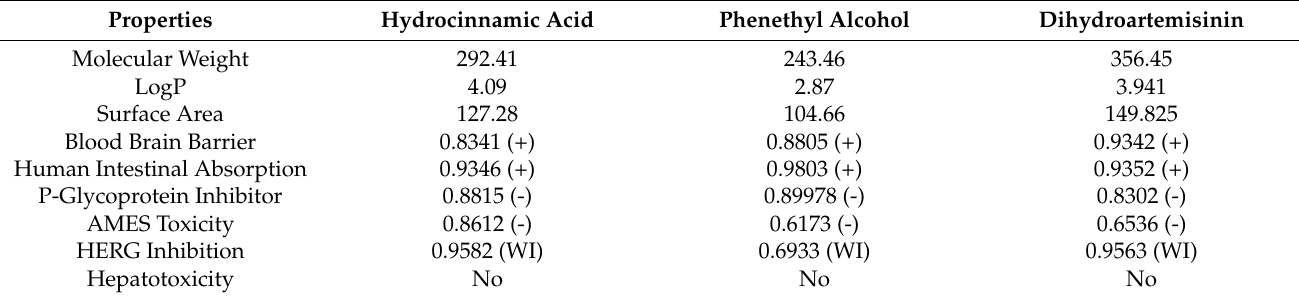
Table 4. The pharmacological assessment of the screened ligand